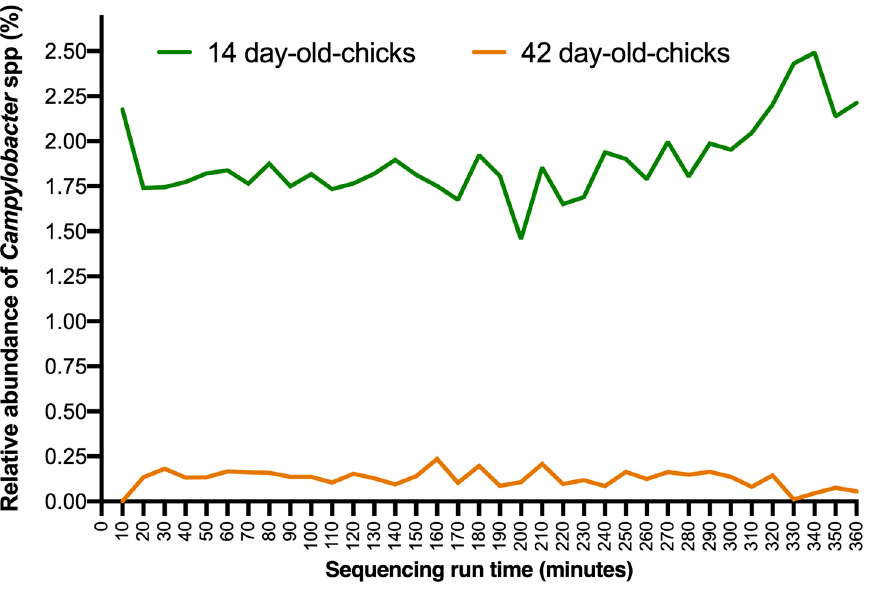
Figure 3. Relative abundance of Campylobacter sequences in caecal samples generated by 10 min over six hours of sequence time using the MinION sequencing device. Table 4. Cost comparison between MinION sequencing and conventional culture for this